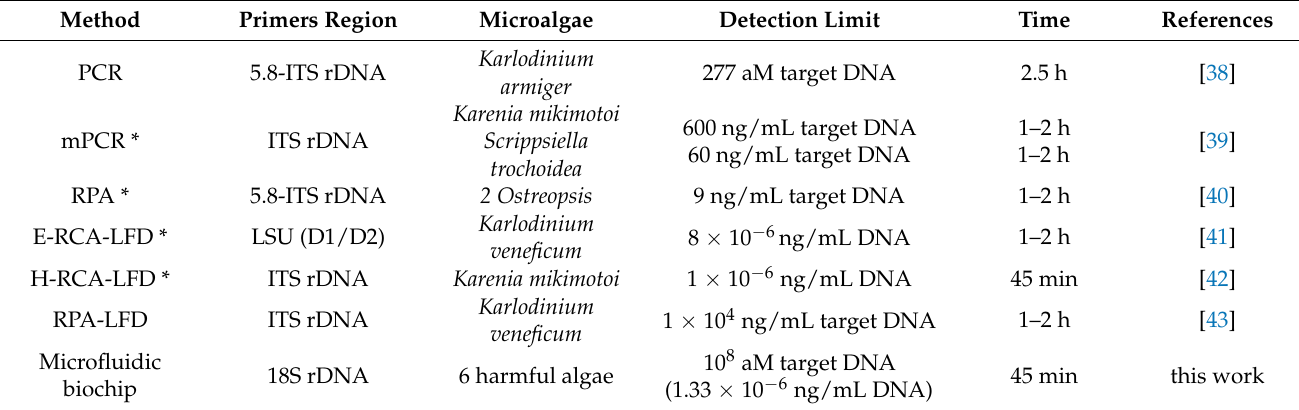
Table 1. Main performance of representative detection methods and the proposed method.